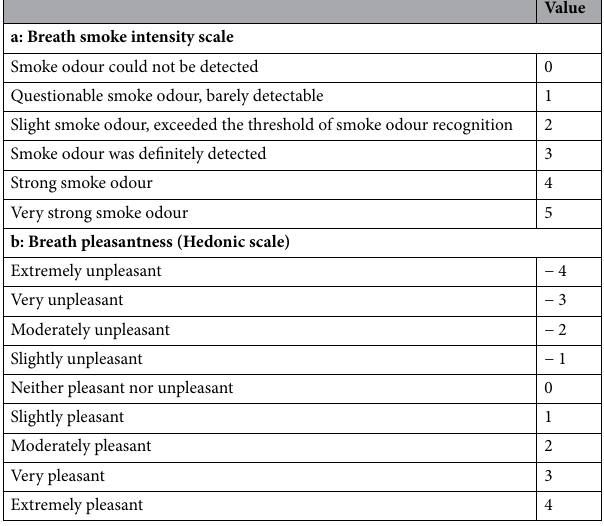
Table 3. Organoleptic scoring scales for smoke intensity and